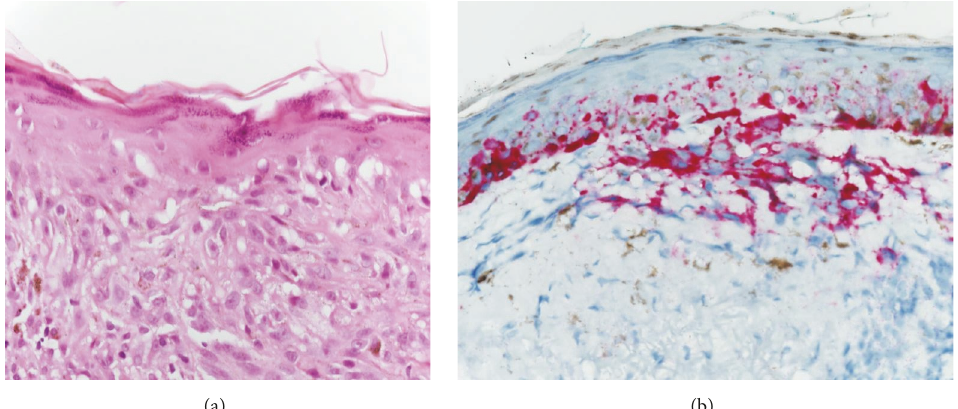
Figure 4: Hematoxylin and eosin-stained section (a) and MART1/Melan A immunostain (b) demonstrating lentigo maligna melanoma of the right cheek (400X power).